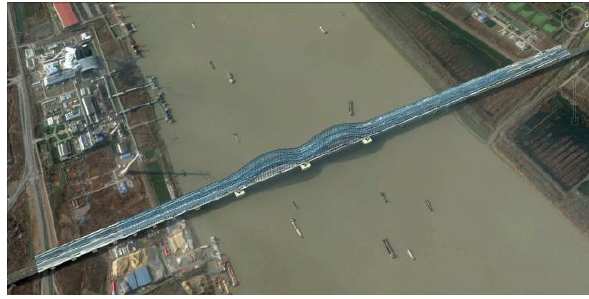
Figure 1. Dashengguan Bridge in Nanjing